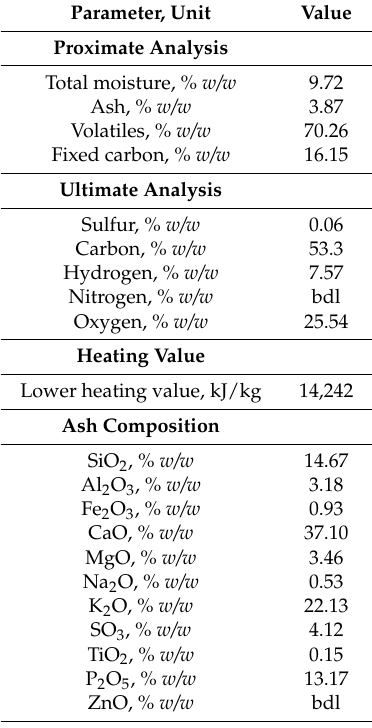
Table 1. Physical and chemical properties of Andropogon gerardi